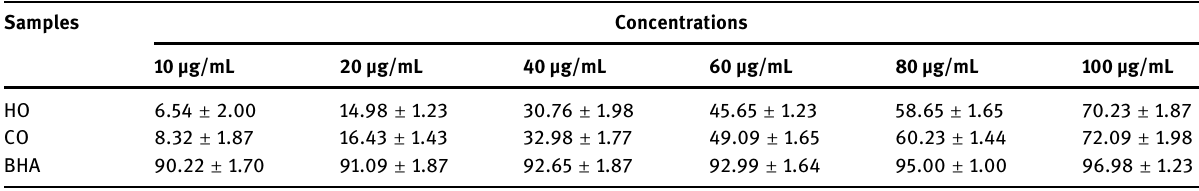
Table 5: Antioxidant e ff ects of oil extracts from HO and CO fractions of F. benghalensis